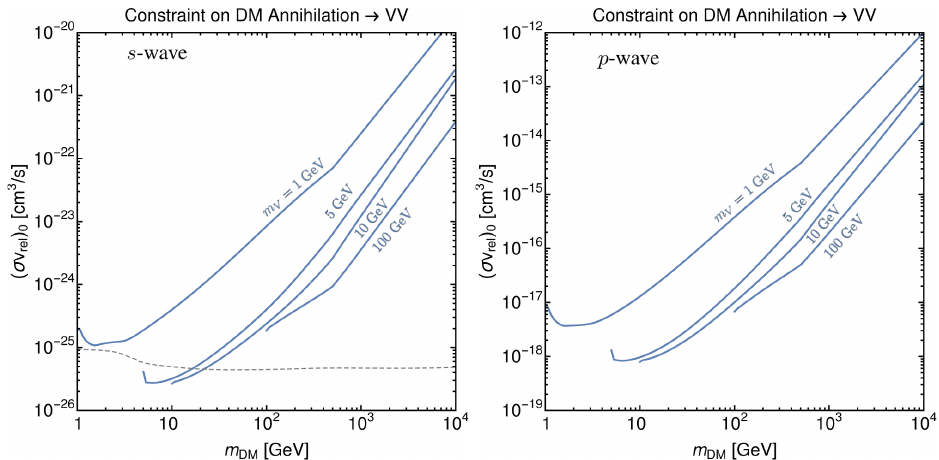
Figure 11: Left: constraint on the generic s -wave DM annihilation cross section for different dark photon masses. The thermal relic line for non-self conjugate DM is also shown (dashed line). Right: same but for a generic p -wave cross